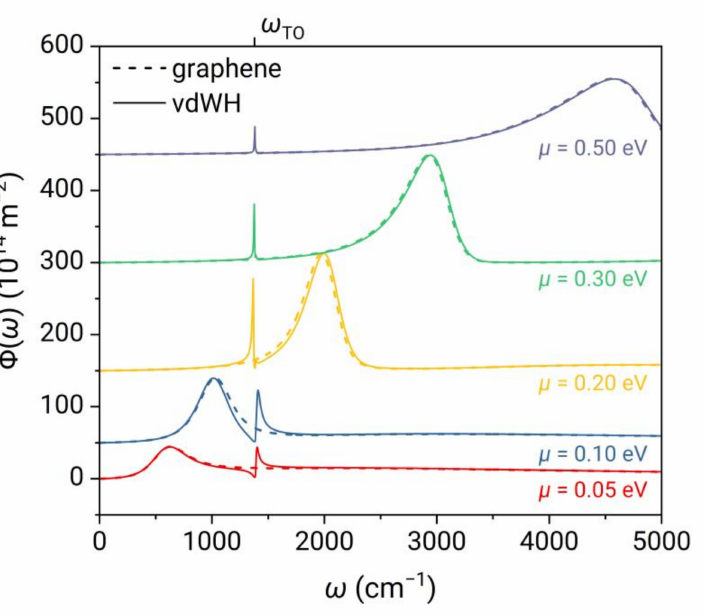
Figure 5. Energy transfer function Φ ( ω ) as a function of frequency for 2D vdW heterostructure and monolayer graphene at different chemical